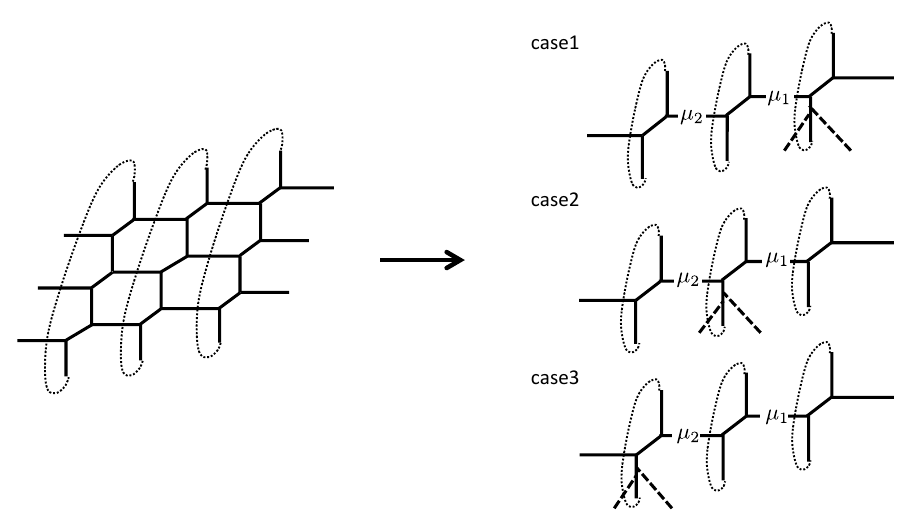
Figure 9 . In this geometric transition we obtain the T -operator for A